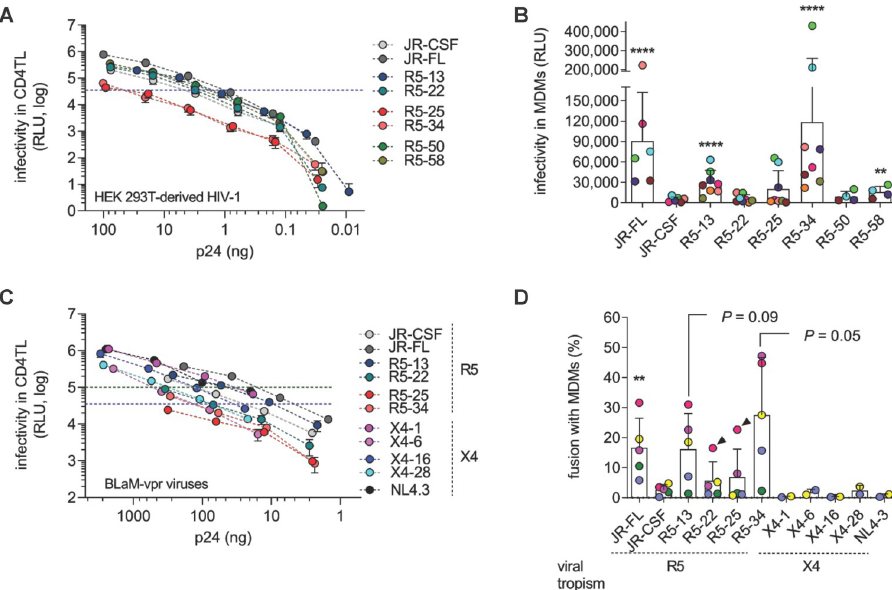
Fig 1. Cell-free T-tropic HIV-1 particles enter and infect MDMs at low efficiency. A) The infectivity of cell-free viruses pseudotyped with the indicated R5 Envs was measured in PHA/IL-2-activated CD4TL as a function of the Gag p24 content in serially diluted supernatants from HEK 293T producer cells. Results (means ± SEM of three independent experiments) show the luciferase activity in the lysates of infected cells, expressed as relative light units (RLU), measured 48 h post-inoculation. The dashed line depicts the infectious dose of the different viruses that was subsequently used to infect MDMs (35,000 RLU equivalents). B) Infectivity of the different viruses in MDMs. Each point represents the average infectivity of 3 replicates measured with the MDMs from one donor. MDMs from different donors were used, each depicted by a color code. For each virus, infectivity is expressed as means ± SD of the different measurements that were carried out with the MDMs from the different donors. C) Infectivity of BLaM-vpr- containing viruses pseudotyped with the indicated R5 or X4 Envs in activated CD4TL, expressed as in panel ( A ). BLaM-vpr containing viruses were concentrated by centrifugation and then diluted to different p24 concentrations before being exposed to target cells. The dashed lines indicate the two infectious doses of viruses that were subsequently used to infect MDMs (35,000 or 100,000 RLU equivalents). D) Percentage of viral fusion with MDMs, expressed as means ± SD of experiments carried out with MDMs from distinct donors. Each donor is depicted by a color code. X4 viruses were used at an infectious dose of 100,000 RLU equivalents, R5 viruses at an infectious dose of 35,000 RLU (except MDMs depicted by purple dots which were infected with 100,000 RLU). Strawberry-colored symbols (arrowheads) represent the results obtained with one donor’s MDMs that were also used in experiments shown in panel ( B) . Statistics were run using the Mann-Whitney U-test: �� , P < .01; ���� , P < .0001.